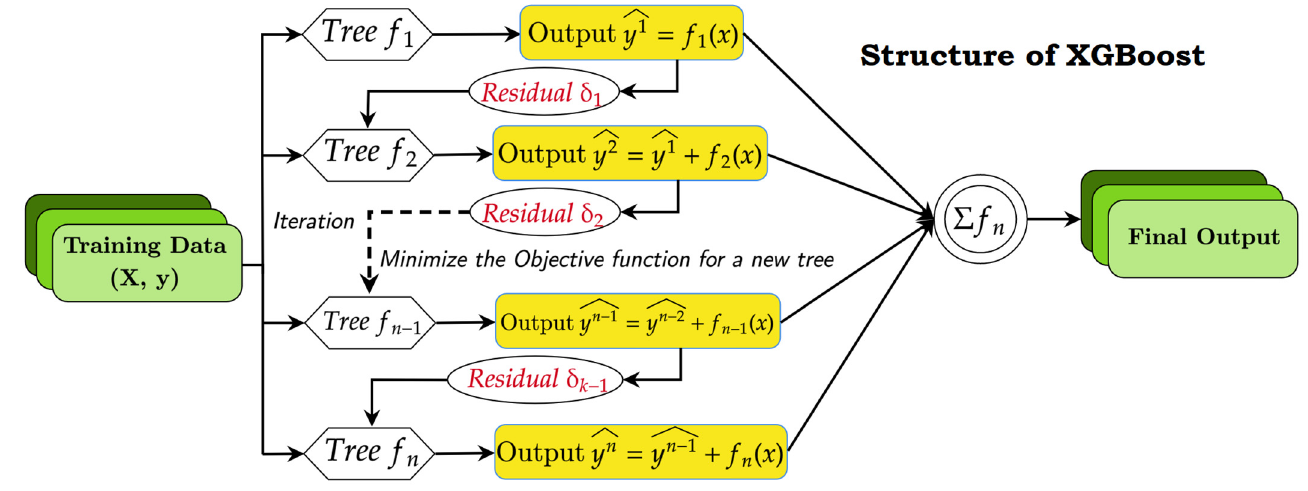
Figure 2. Structure of the XGBoost model.